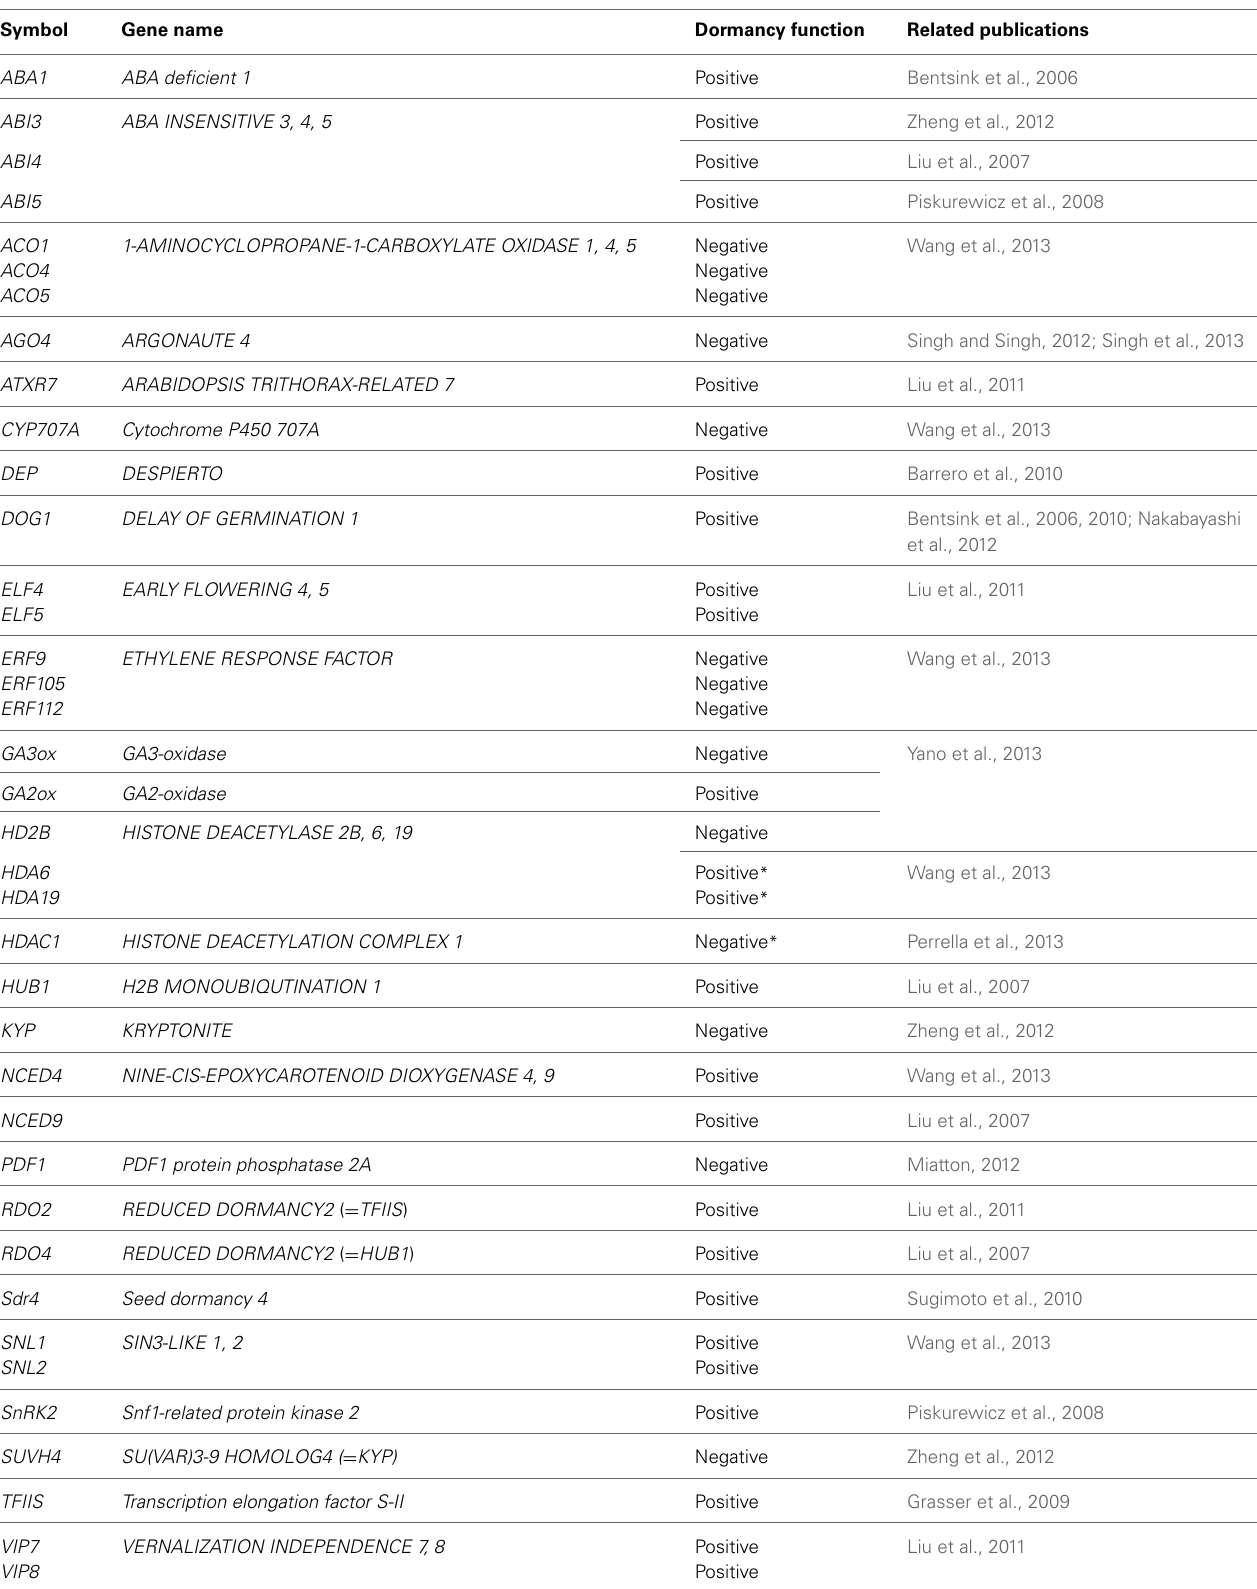
Table 1 | Seed dormancy associated genes described in this